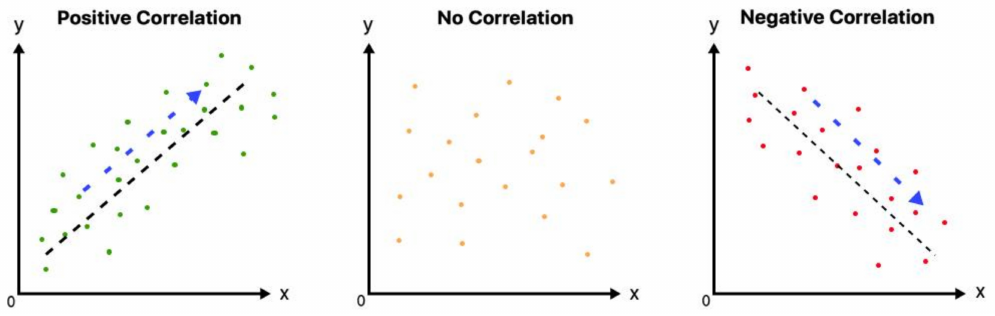
Figure 2. Linear correlation diagrams.